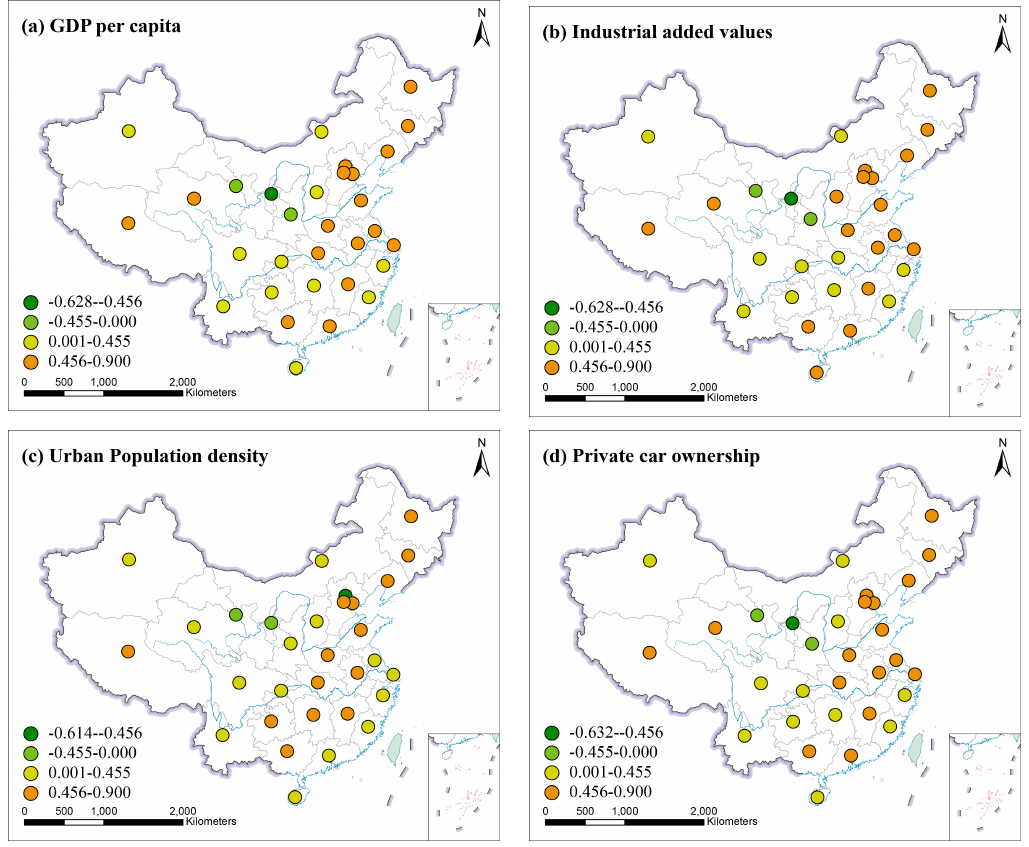
Figure 7. The correlation coefficient (r) values in 31 provinces. ( a ) Correlation between PM 2.5 and GDPP. ( b ) Correlation between PM 2.5 and IVA. ( c ) Correlation between PM 2.5 and UPD. ( d ) Correlation between PM 2.5 and PCO.